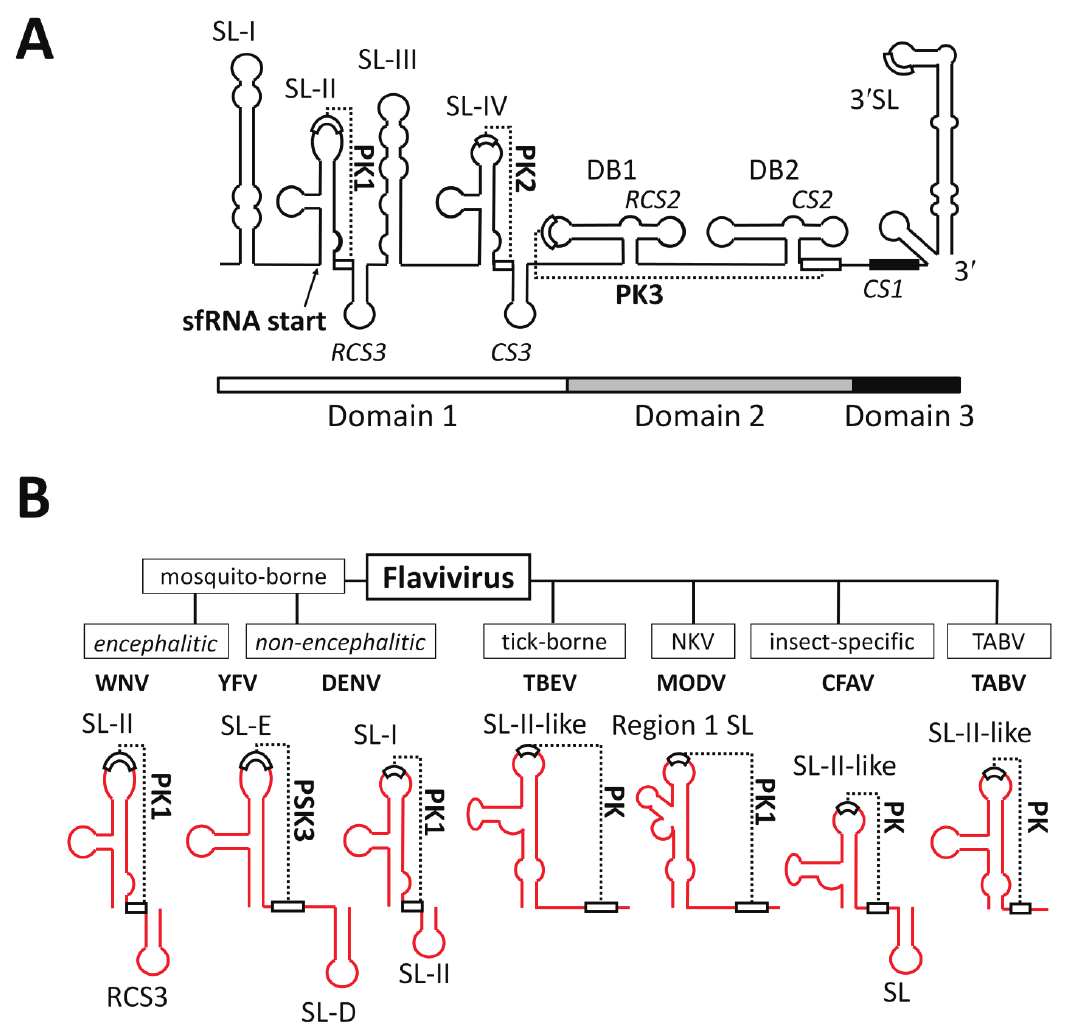
Figure 2. Structural elements within the 3'UTR of WNV and conservation of SL-II within the genus Flavivirus . ( A ) Schematic representation of the 3'UTR of WNV demonstrating the arrangement of stem-loops (SL) and pseudoknots (PK) and the sfRNA 5'-terminus. Modified from Pijlman et al. , 2008 [18] and Funk et al. , 2010 [19]; ( B ) Schematic representation demonstrating the predicted conservation of the SL-II/PK1-like RNA structure within the 3'UTR of divergent members of the genus Flavivirus